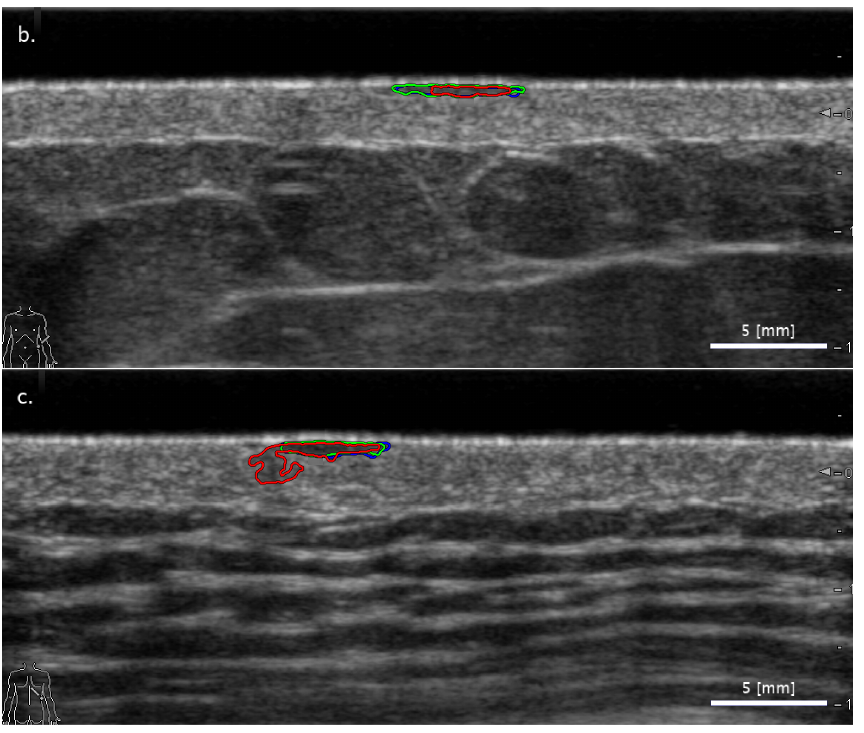
Figure 3. Examples of images with segmentation results leading to a correct ‘Nevus vs. others’ type binary classification in the cases of both SA methods (freehand: blue mark; LAR: green mark) while failing the classification results for the FA method (red mark). Three typical cases are